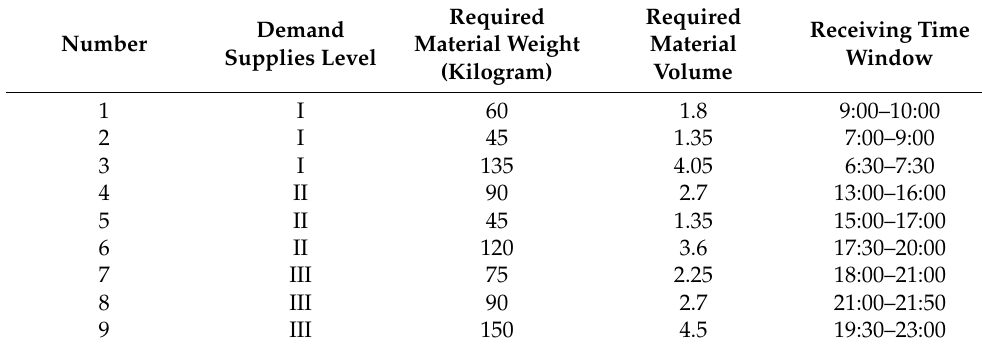
Table 5. Demand material information and delivery time window at each demand point.